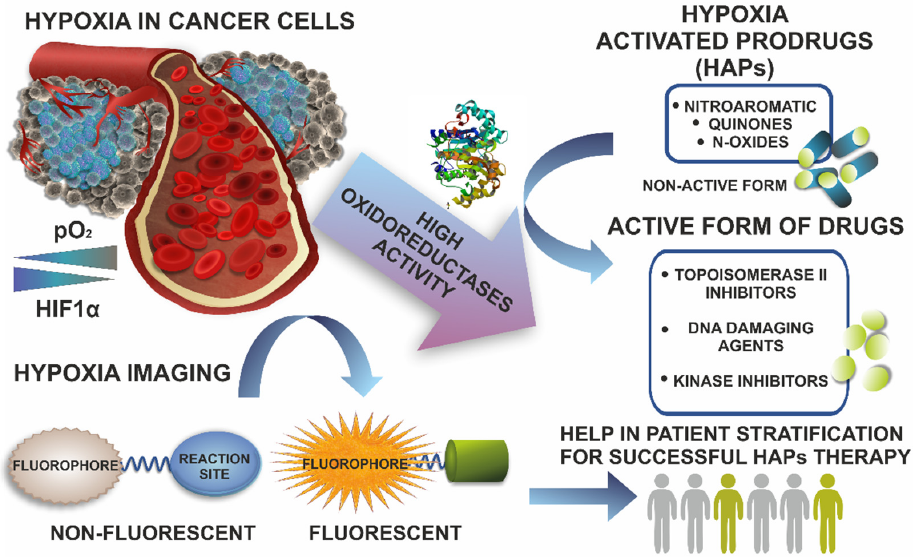
Figure 6. The overview of the role of oxidoreductases in hypoxia-activated prodrugs (HAPs) therapy and imaging of hypoxia.